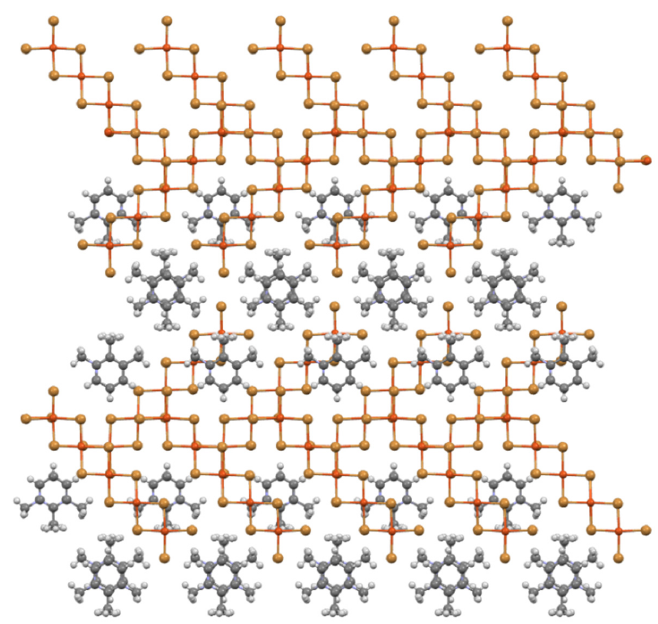
Figure 7. Ball-and-stick diagram of two mixed organic cation/oligomer sheets stacked together and viewed perpendicular to the (30 2(cid:3364) ) plane.